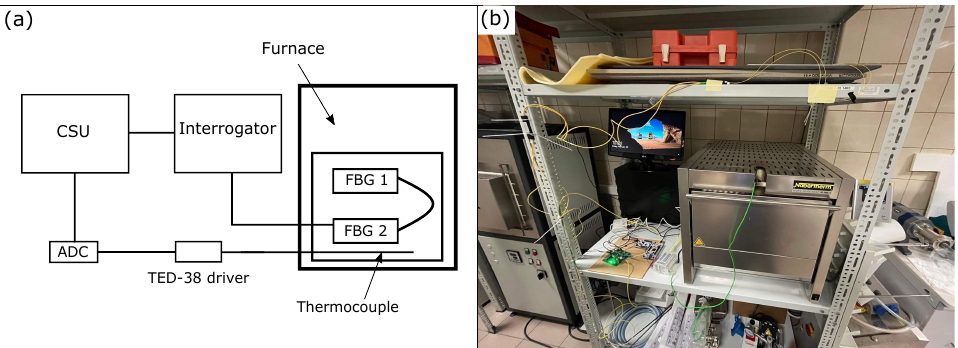
Figure 9. Architecture of the measurement bench ( a ), which consists of a CSU, an optical interrogator, two FBG-based sensors, and a thermocouple, which is considered to provide the reference temper- ature measurement. The measurement bench, together with the picture of the heating furnace, is presented in ( b ).